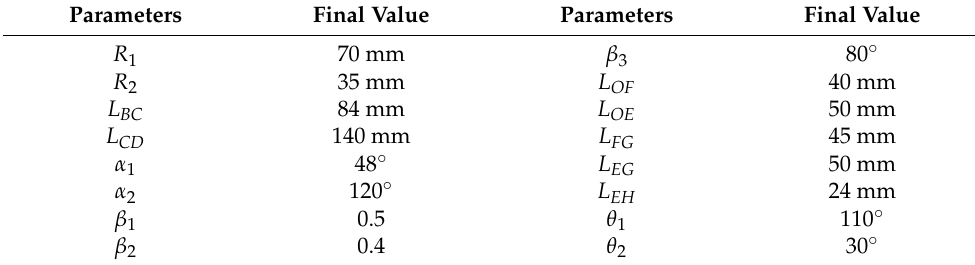
Figure 8. Flow chart of structural parameter optimization. Table 1. Final structure parameters.